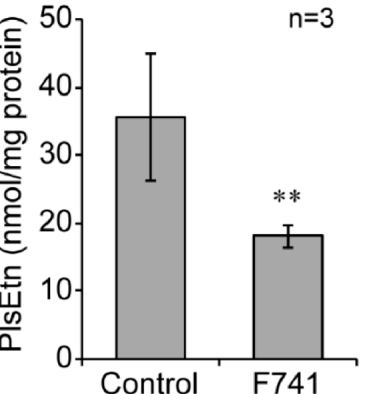
Figure 9. Plasmalogens are decreased in fibroblasts from a NME3-deficient patient. Ethanolamine plasmalogens (PlsEtn) in fibroblasts from a healthy control and the patient F741 were determined by LC-MS/MS (n = 3). Data indicate means ± SD. ** p < 0.01, by Student’s t